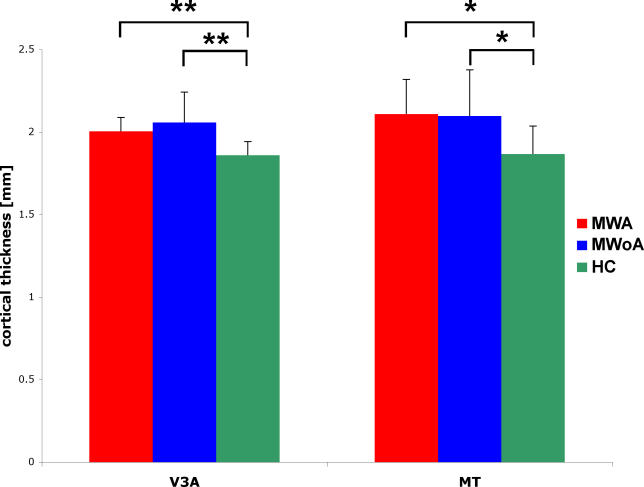
Cortical Thickness Is Increased in Motion-Processing Areas in MigraineursValues are presented in mean millimeters (SD). V3A: MWA, 2.00 (0.09); MWoA, 2.06 (0.19); HCs, 1.86 (0.08). MT+: MWA, 2.11 (0.21); MWoA, 2.10 (0.88); HCs, 1.87 (0.17). Asterisks represent p-value summary * p < 0.05; ** p < 0.01